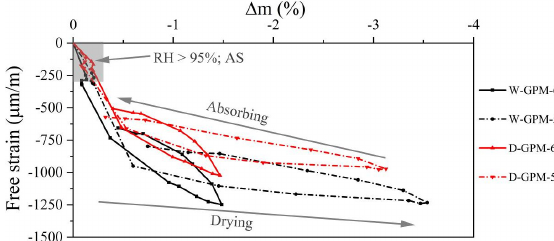
Figure 10. Free strains (shrinkage and expansion) vs mass variation (loss or gain) during length change measurements on prisms under different RH.